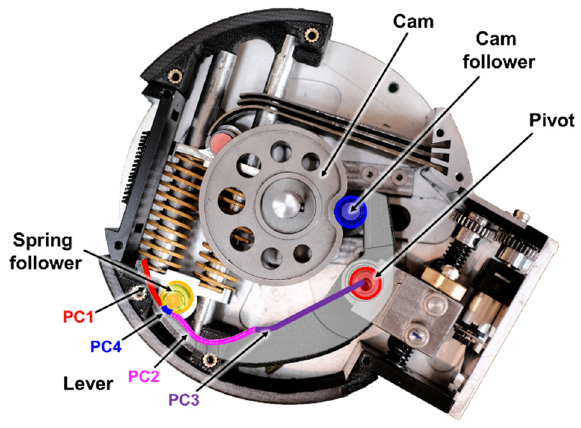
Figure 8. Manufactured CVGC mechanism with the designed lever contour. To verify the subfunction of PC1, the position of the spring follower was measured by marker tracking when the position of the pivot changed. Although a minor position. change of the spring follower occurred, PC1 successfully minimized the movement, as shown in Figure